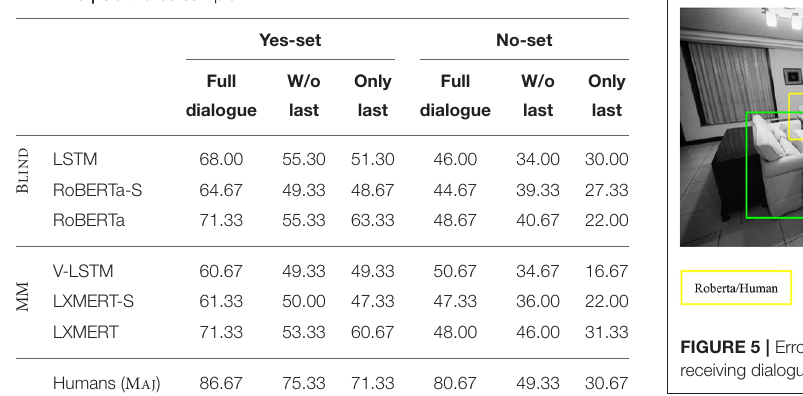
TABLE 8 | Controlled sample.